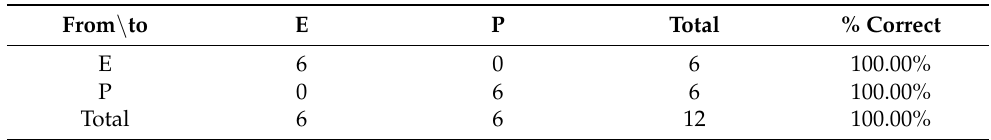
Table 4. Confusion matrix for the validation sample (VAR–E/P).